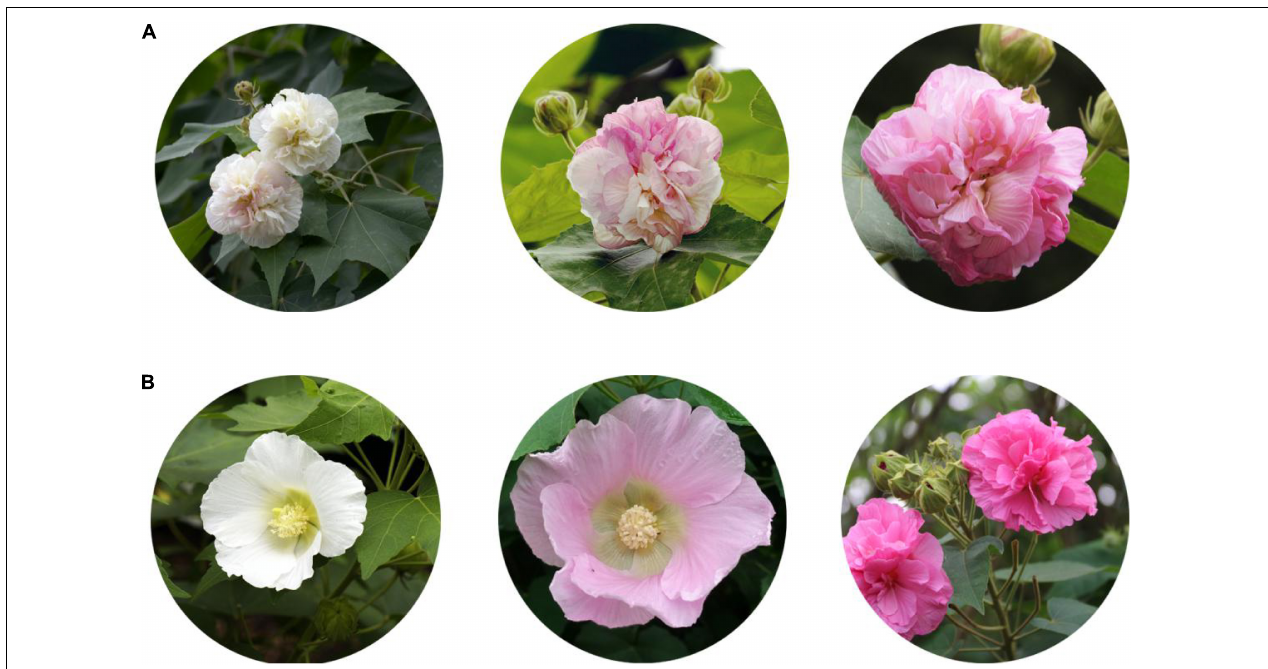
FIGURE 1 | Hibiscus mutabilis floral morphology. (A) Dynamic change in the flower color of H. mutabilis f. mutabilis ‘Drunk girl’ from white to pink. (B) A variety of colors found in different color cultivars of H. mutabilis , and from left to right in turn are H. mutabilis ‘Single-Petal Pink,’ H. mutabilis ‘Single-Petal White’ and